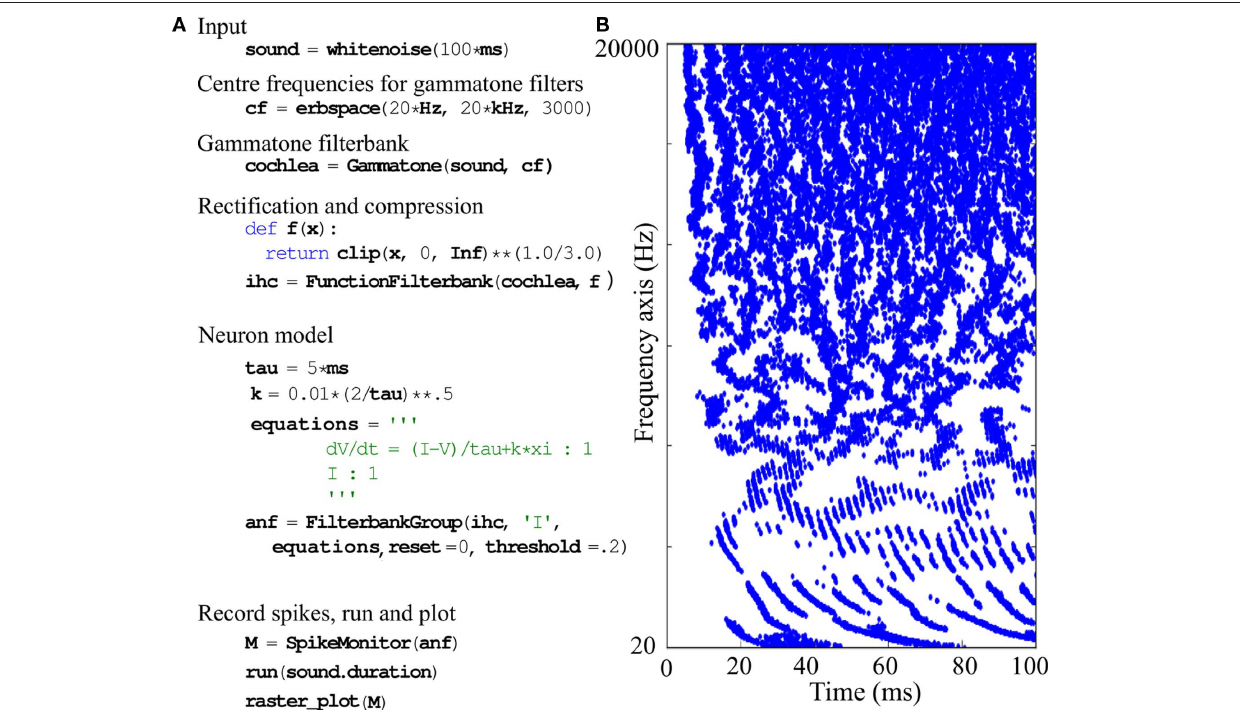
FiGUre 1 | Simple spiking model of the auditory periphery. The cochlea and inner hair cells are modeled using gammatone filtering followed by half-wave rectification and 1/3-power law compression. We model the auditory nerve fibers as leaky integrate-and-fire neurons defined by the stochastic differential equation